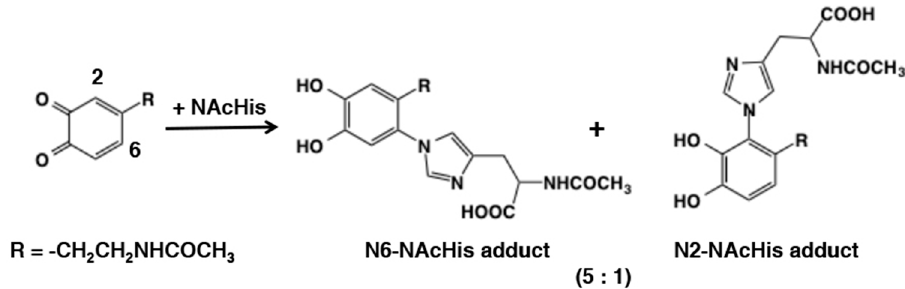
Figure 11. Reaction of o -quinones with N -acetylhistidine. Note that the position of attachment of the imidazole group was confirmed [57].